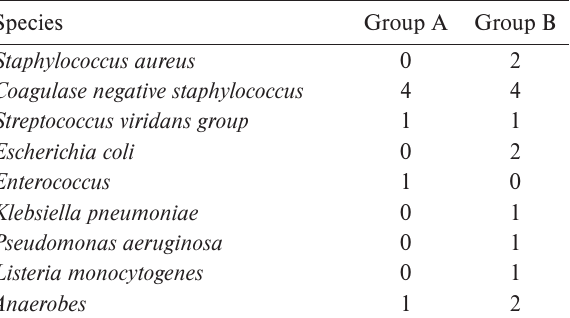
Table 2. Identified bloodstream infection species.